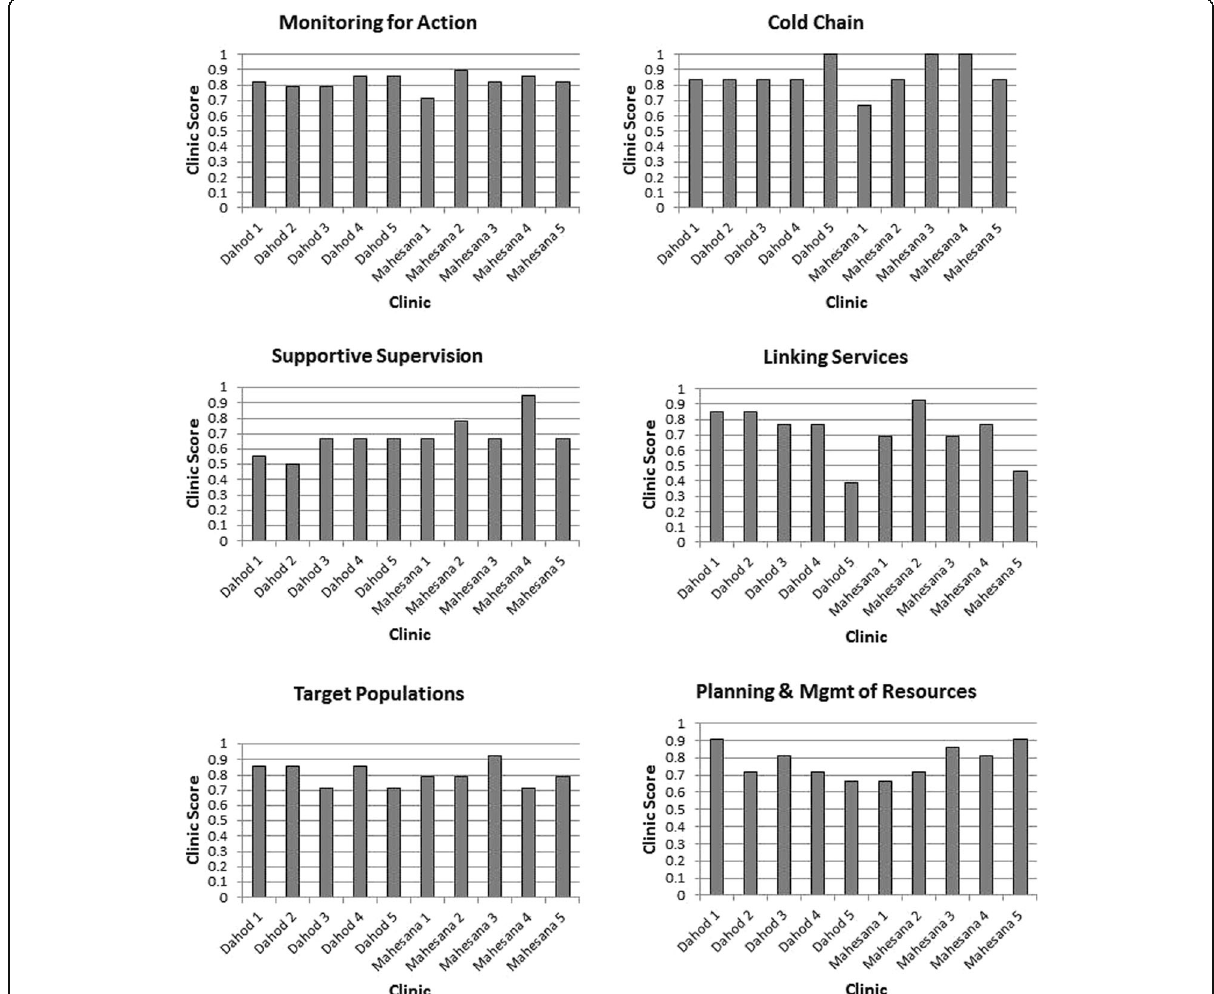
Fig. 1 Comparison of index-based scores across 10 PHCs in Gujarat,